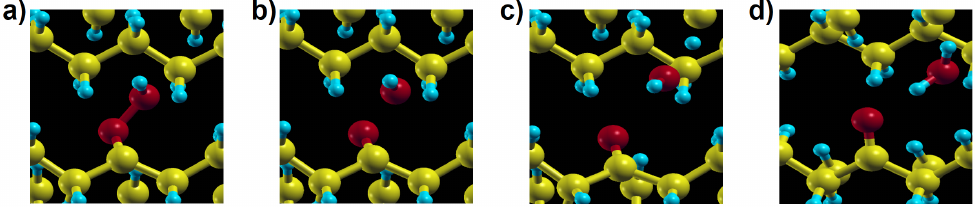
Figure 5. Energy profiles for reactions labeled 3a–c in Figure 2. Panels ( a – c ): H-abstractions from γ , β , α , respectively, in a molecular model. Panels ( d – f ): analogous reactions for crystalline PE.